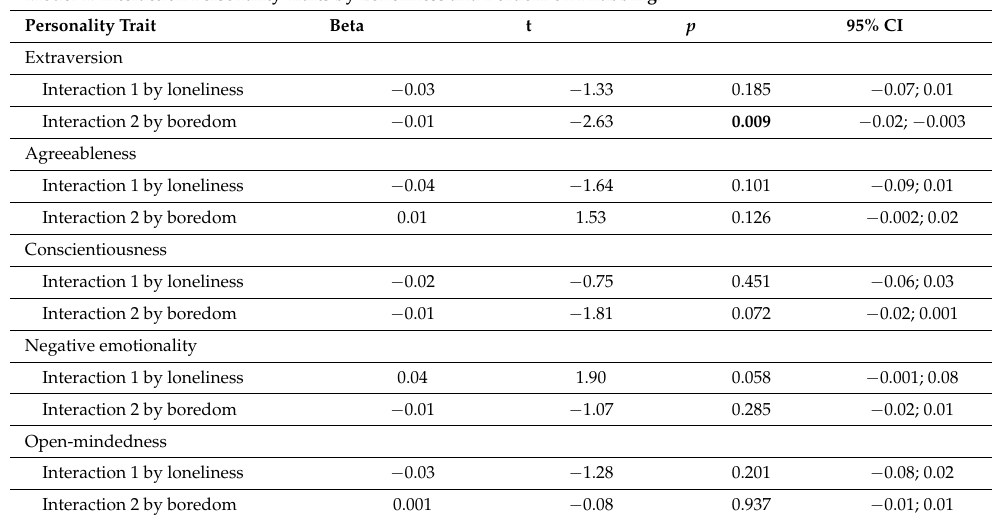
Table 5. Interaction analyses. Model 1: Interaction Personality Traits by Loneliness and Bordom on Phubbing.